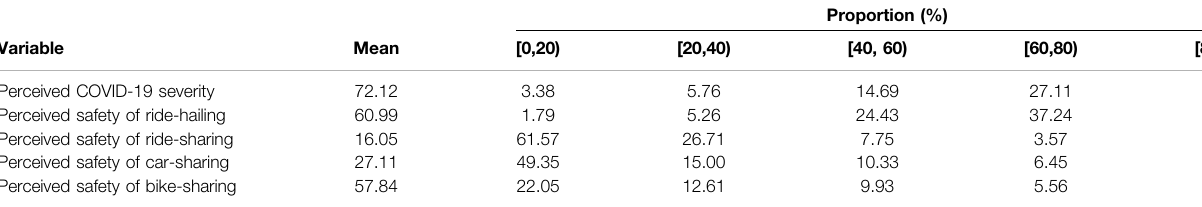
TABLE 3 | Statistics of respondents ’ perceived COVID-19 severity and perceived safety of each shared mobility service.